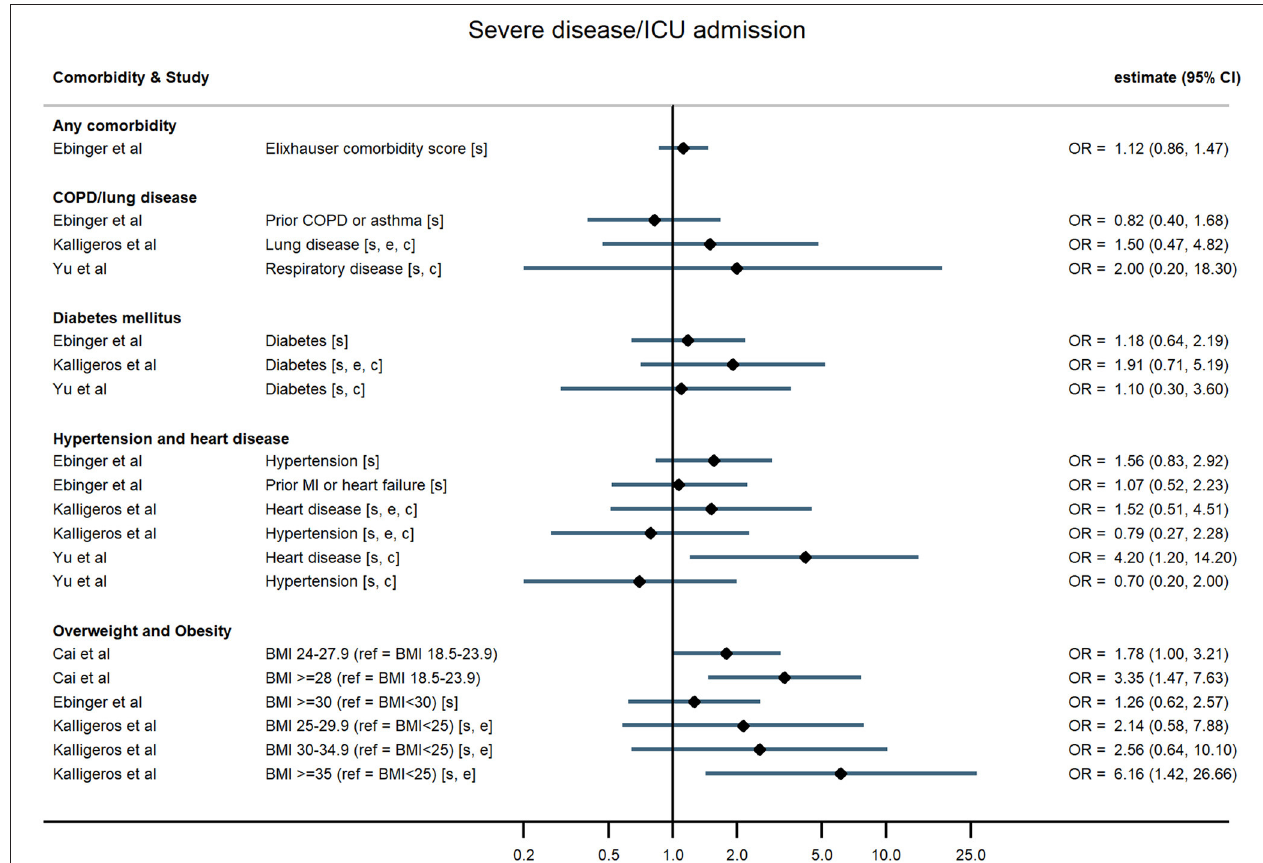
FIGURE 4 | Forest plot of study estimates of the association between comorbidities and progression to severe disease or intensive care unit admission among hospitalized COVID-19 patients in the early stages of the pandemic. Reference category for each comorbidity is the absence of that comorbidity, except where stated otherwise. ICU, intensive care unit; OR, odds ratio; CI, confidence interval; BMI, body mass index; COPD, chronic obstructive pulmonary disease; MI, myocardial infarction. All estimates adjusted for age. Additionally adjusted for: sex [s]; other comorbidities [c]; ethnicity